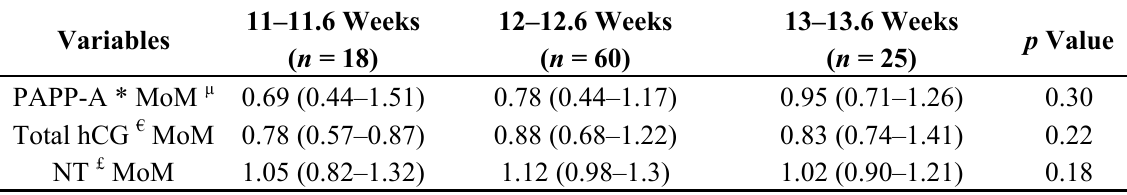
Table 4. Gestational age related effects of PGDM † on first trimester screening